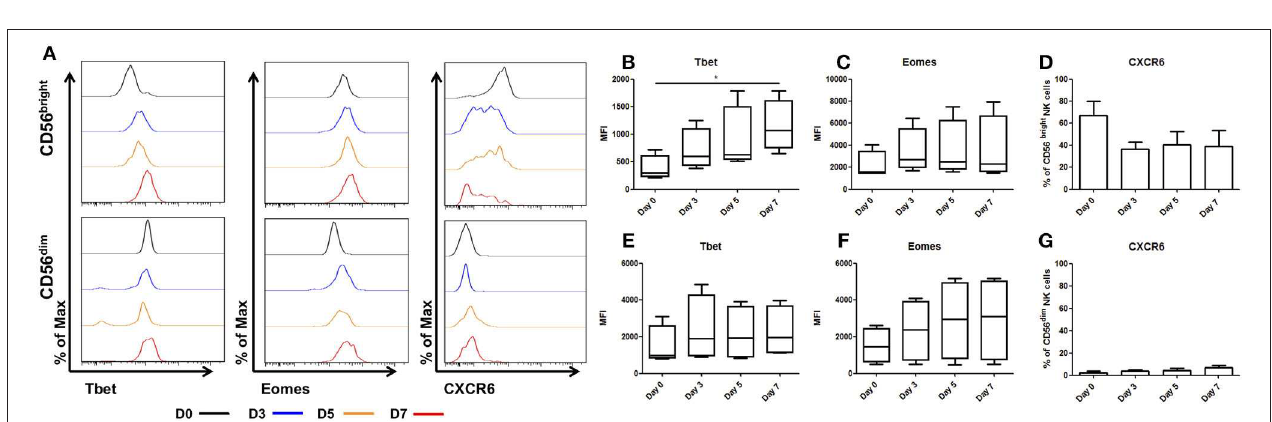
FIGURE 2 | Tbet expression increases in liver resident NK cells cultured ex vivo. NK cells isolated from liver perfusate (LP) were cultured for 7 days and stained with monoclonal antibodies to assess transcription factor expression. (A) Representative histograms of Tbet, Eomes and CXCR6 expression from cells at day 0 (black line), day 3 (blue line), day 5 (orange line), and day 7 (red line). (B) MFI of Tbet in CD56 bright NK cells from LP at day 0, 3, 5, and 7. (C) MFI of Eomes CD56 bright NK cells from LP at day 0, 3, 5, and 7. (D) Percentage of CXCR6 positive CD56 bright NK cells from LP at day 0, 3, 5, and 7. (E) MFI of Tbet in CD56 dim NK cells from LP at day 0, 3, 5, and 7. (F) MFI of Eomes in CD56 dim NK cells from LP at day 0, 3, 5, and 7. (G) Percentage of CXCR6 positive CD56 dim NK cells from LP at day 0, 3, 5, and 7. Data presented as mean ± SEM (D,G) or box and whisker plots with minimum and maximum values (B,C,E,F) . Data was analyzed using Friedman test, with Dunn’s multiple comparison test ( n = 5; * p < 0.05).